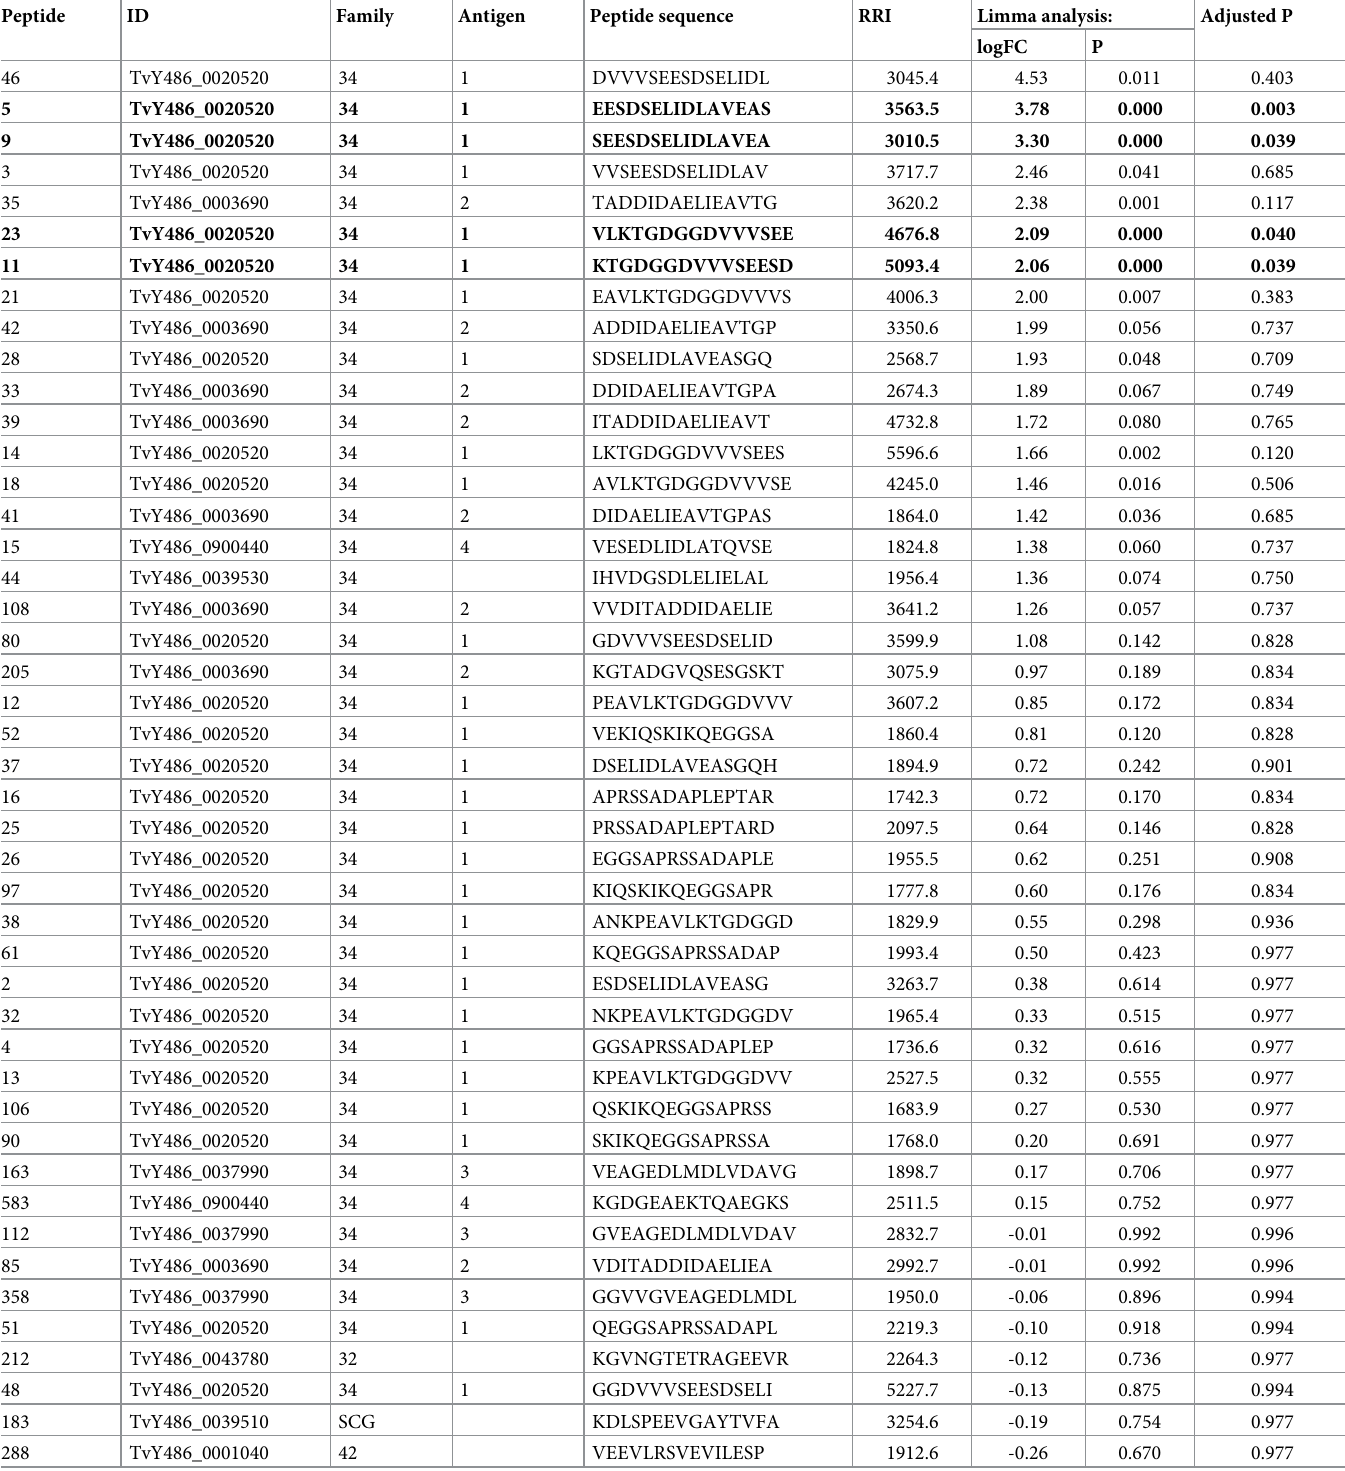
Table 1. Parasite peptides displaying the strongest responses to host antibodies in an immuno-profiling assay of T . vivax -infected serum, across all locations, show- ing the highest 10% of raw response intensity (RRI) values, ranked by fold change relative to uninfected controls.